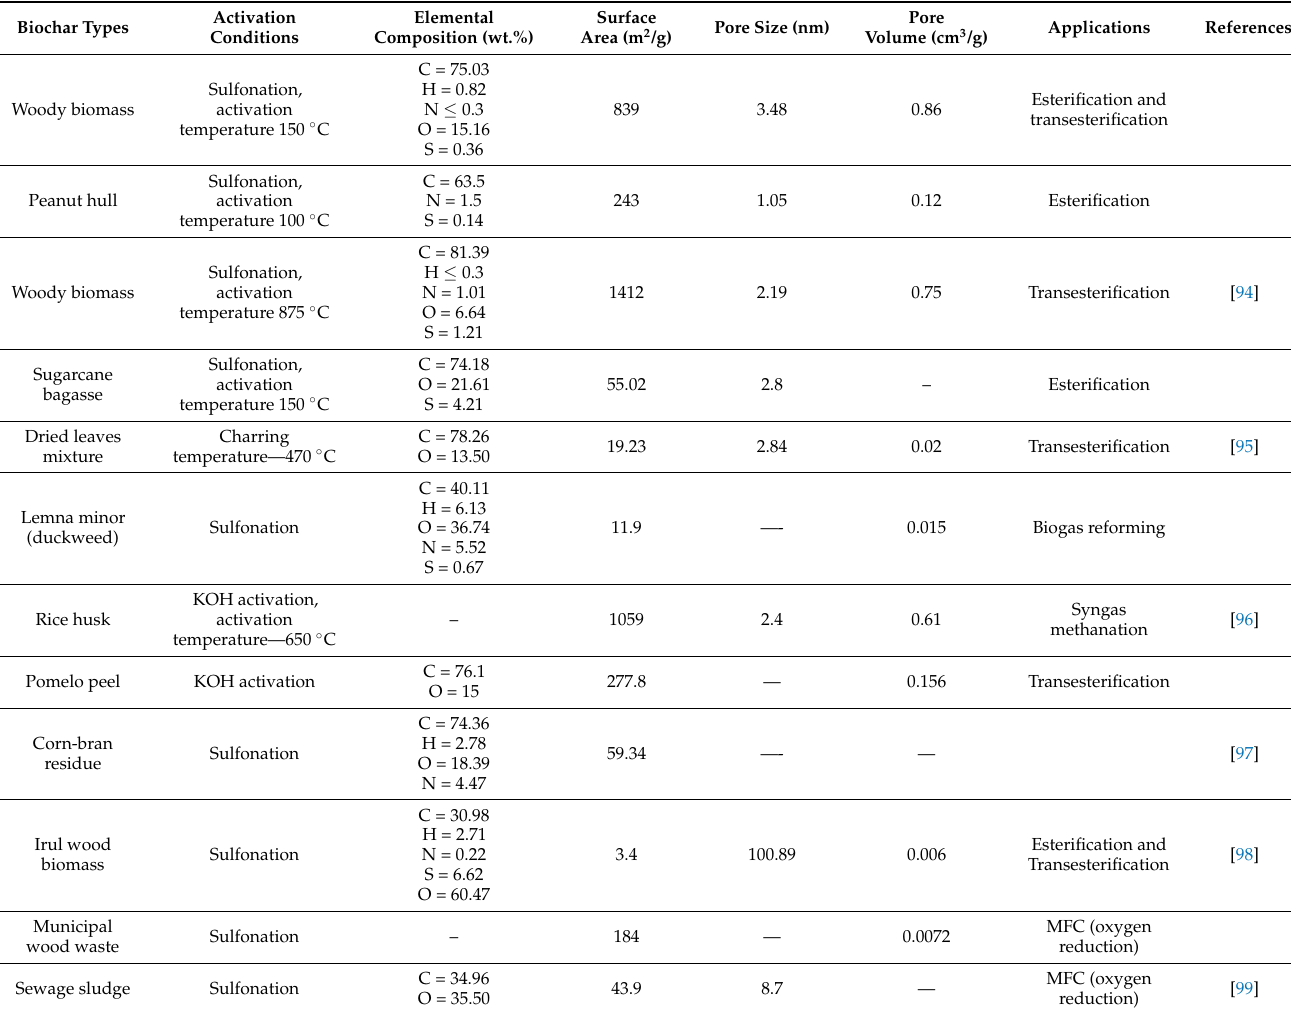
Table 4. Utilizations of biochar as a catalyst derived from a variety of biomass